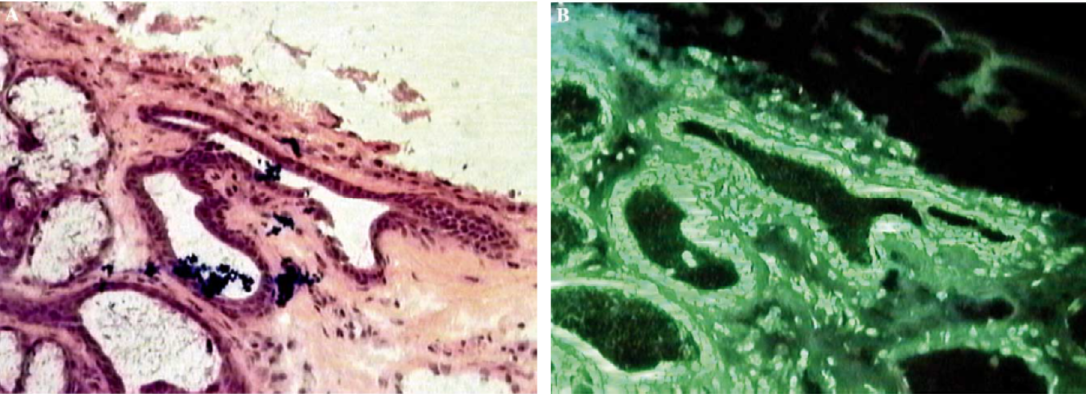
Figure 7. ( a ) Hematoxylin and eosin coloring technique. ( b ) Coloring with quinolone–lanthanide complexes, with permission from [182].